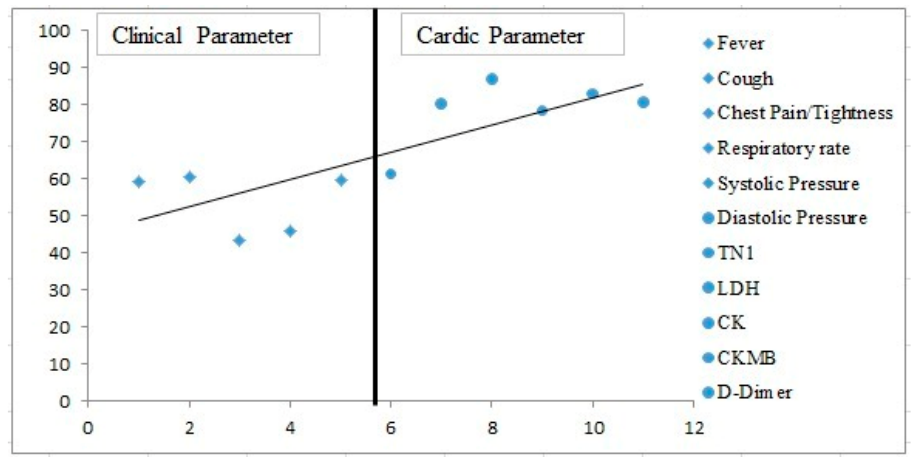
Figure 1. Scatter plot showing correlation among clinical parameters and cardiac biomarkers.